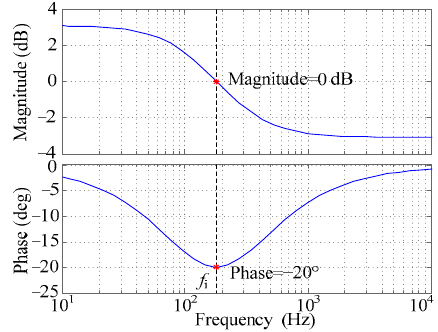
Figure 10. The Bode diagram of the optimization function G p ( s ).